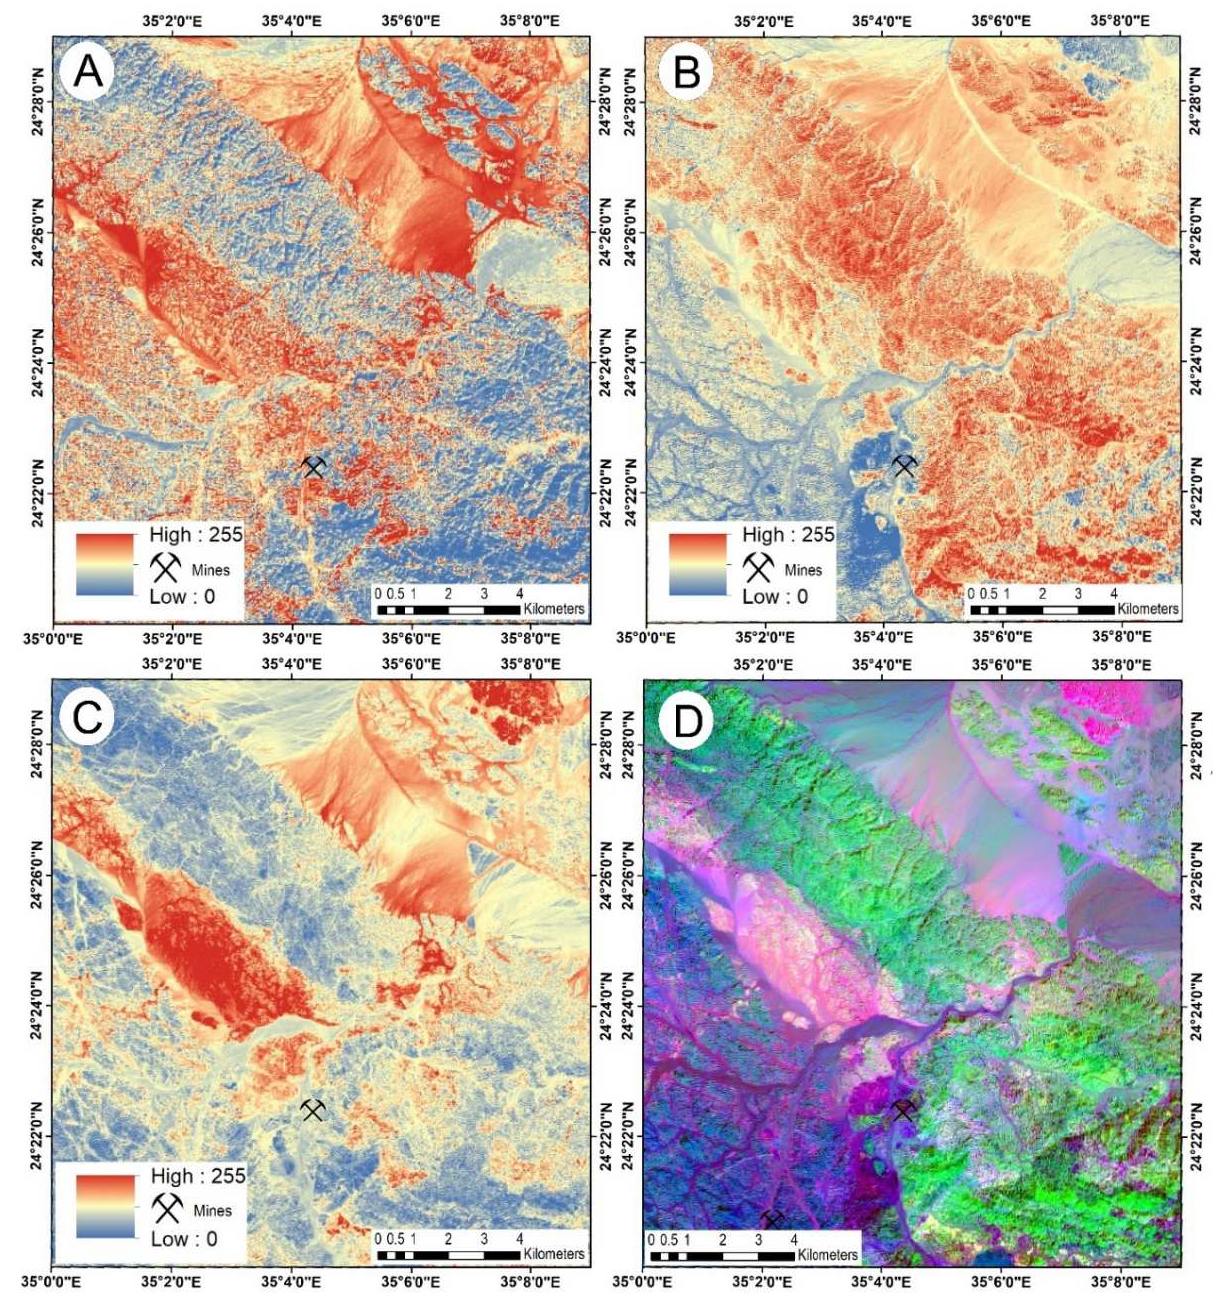
Figure 8. Band-ratio processing of Landsat 8 imagery: ( A ) Band ratio 6/7 for clay alteration mapping. ( B ) Band ratio 6/5 for ferric alteration mapping. ( C ) Band ratio 4/2 for ferrous iron alteration mapping. ( D ) False color composite of 6/7, 6/5, and 4/2.